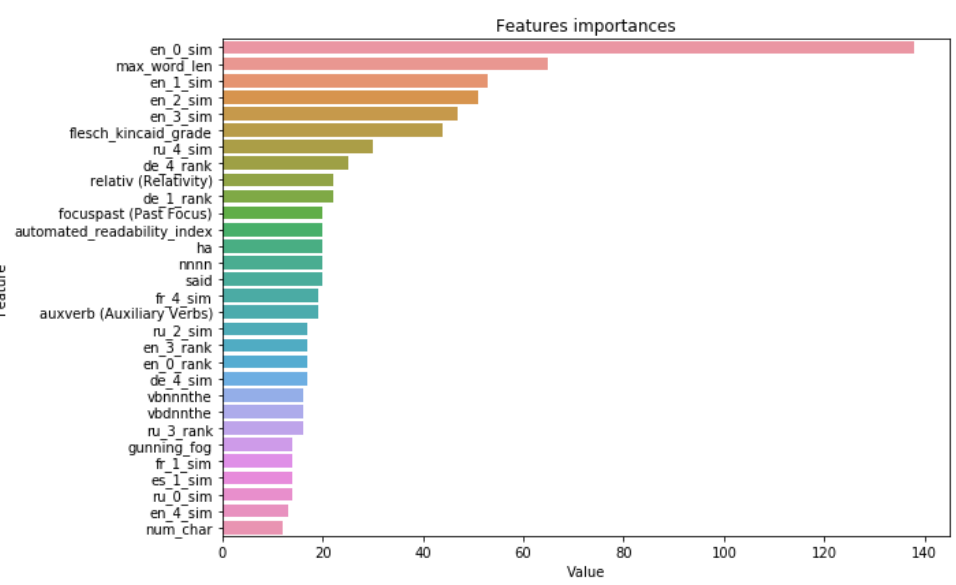
Figure 8. The top 30 feature importance scores of the best model for the FakeNewsAMT dataset: the LightGBM model based on all linguistic + CE Emb. + Rank feature